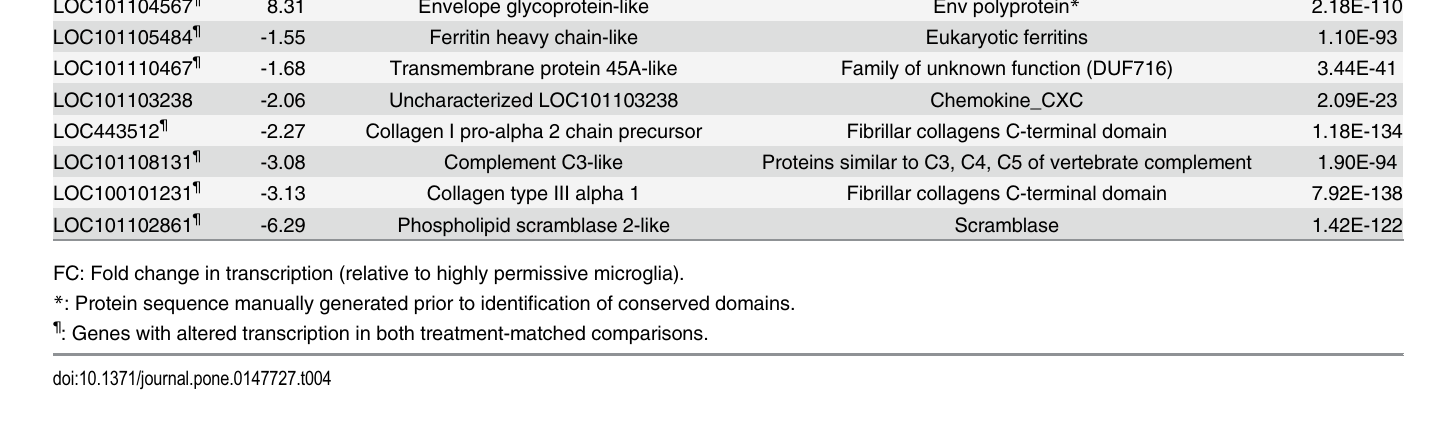
Table 4. Genes encoding for hypothetical proteins with altered transcription in scrapie-inoculated microglia clones. Gene symbol FC